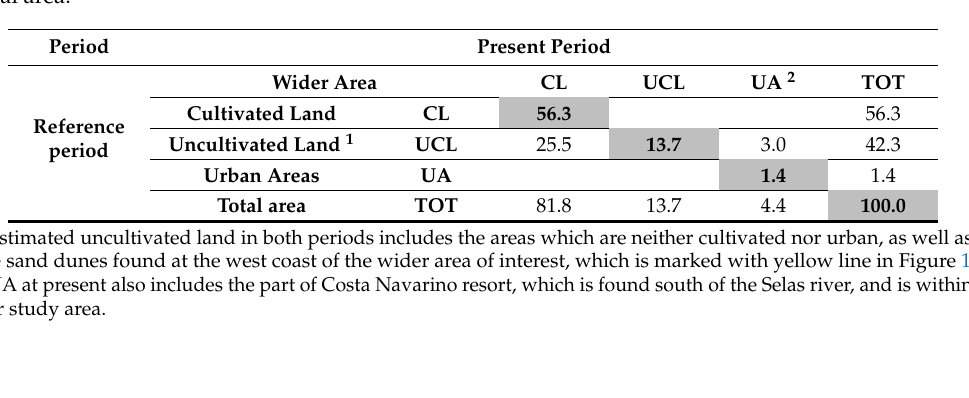
Table 2. Area coverage (percentage with respect to the total wider area) of different classes in the wider area in reference (prior to 1960) and present (2010) periods. The percentage coverage of each class before and after human interventions is given in the right column and last line respectively. Surfaces that do not change (persistence) are displayed on the diagonal of the table. Changes (gains or losses) in area coverage are displayed in the cells outside the diagonal (e.g., 25.5% of the area belonged to the UCL class in the reference period, but became part of the CL class in the present period). Errors attributable to uncertainties in the definition of the land use polygons amount to less than 0.5% of the total